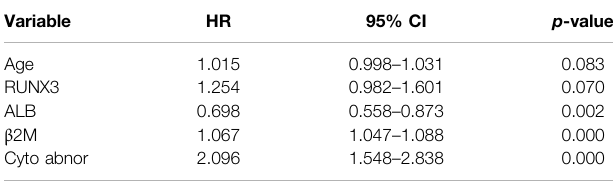
TABLE 2 | Multivariate analysis of OS in MMRF compass dataset. TABLE 3 | Multivariate analysis of OS in GSE24080